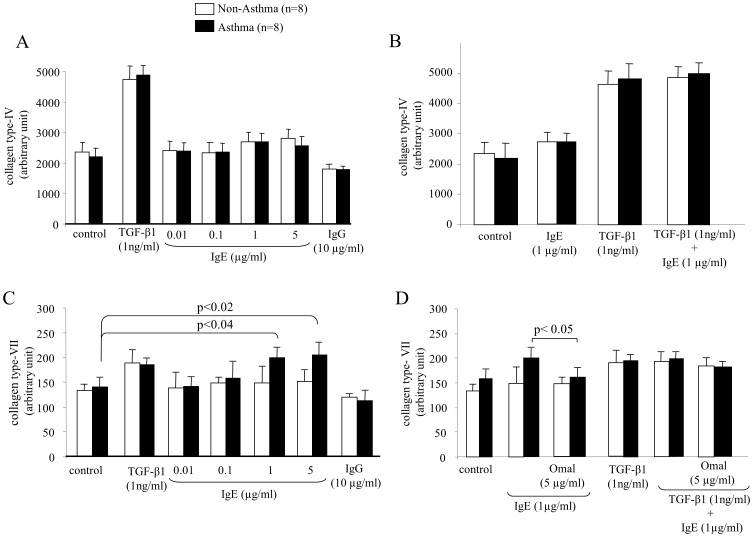
IgE does not increase collagen type-IV deposition, but increases collagen type-VII diseases specifically.(A) IgE does not induce collagen type-IV deposition by ASMC. (B) IgE does not modify TGF-β1-induced collagen type-IV deposition. (C) IgE disease specifically increases the deposition of collagen type-VII by ASMC of asthma patients, (D) but has no additive effect on TGF-β1-induced collagen type-VII deposition.